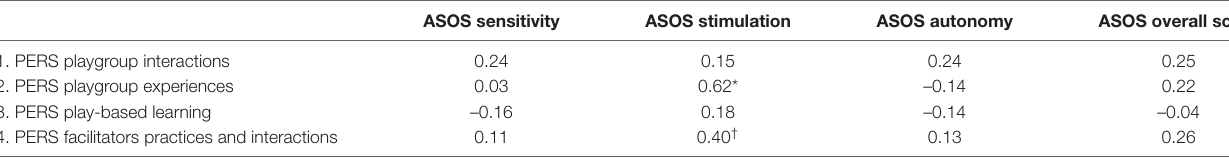
TABLE 8 | Bivariate correlations between PERS dimensions with ASOS subscales and overall score.